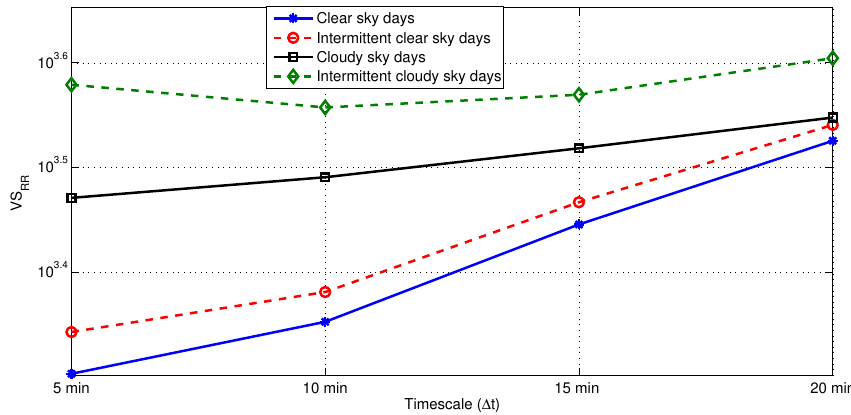
Figure 15. Variability score VS versus timescale ∆ t for each class in 2012 in semi-log